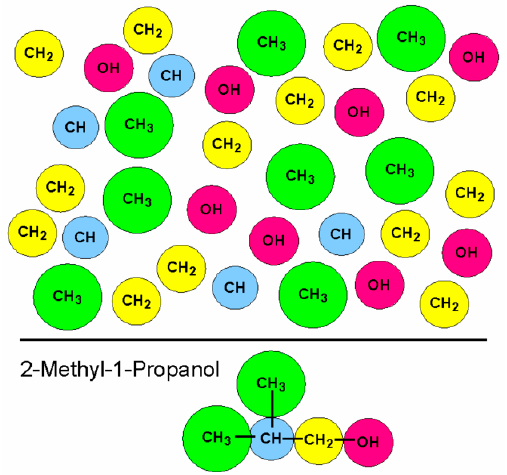
Figure 1. Schematic representation of the Group Contribution concept where the molecule is broken into building blocks.